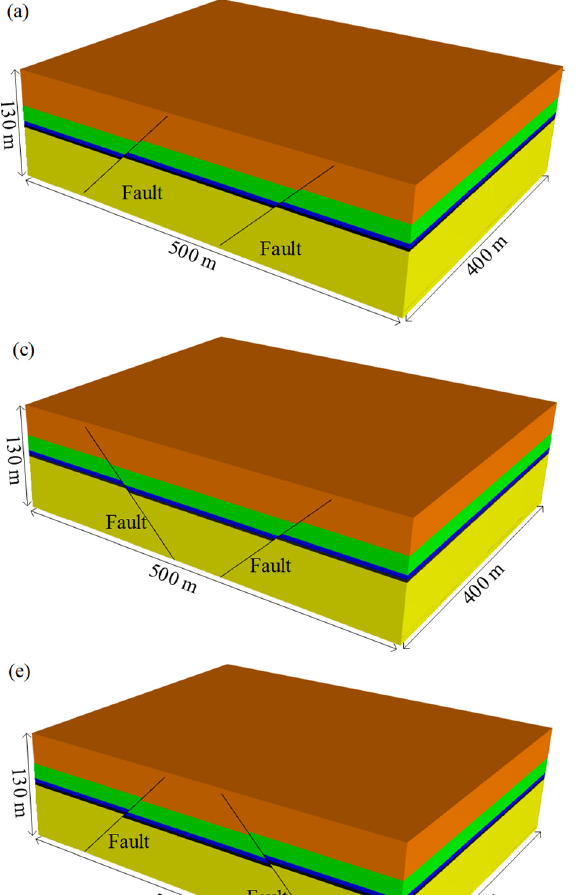
Table 4. Orthogonal test schemes of four factors and three levels (3 4 ). Level (Scheme) / Figure 12a shows the DII distribution of different orthogonal experiment results. For six different combined faults, the distribution of DII is relatively high and close to each other except for some special cases, which indicates that the excavation of the longwall face in the middle of the faults leads to lateral abutment pressure, and the existence of faults on both sides leads to stress concentration near the faults. Furthermore, the similar DII distribution of different combined faults indicates that the correlation between stress concentration and faults type is weak. Additionally, for a special two combined faults type, the difference of DII among different experimental schemes was also small except for some cases, which means that the longwall face will always be affected by high static stress when mining near the combined faults and targeted prevention and control measures should be implemented. Figure 12b shows the I V distribution of different orthogonal experiment results. It can be seen that the I V distribution varies among different combined faults, in which all exper- imental schemes have relatively low I V values in back thrust fault and graben fault models and the rest of the models have relatively high I V values. Furthermore, it is noticed that